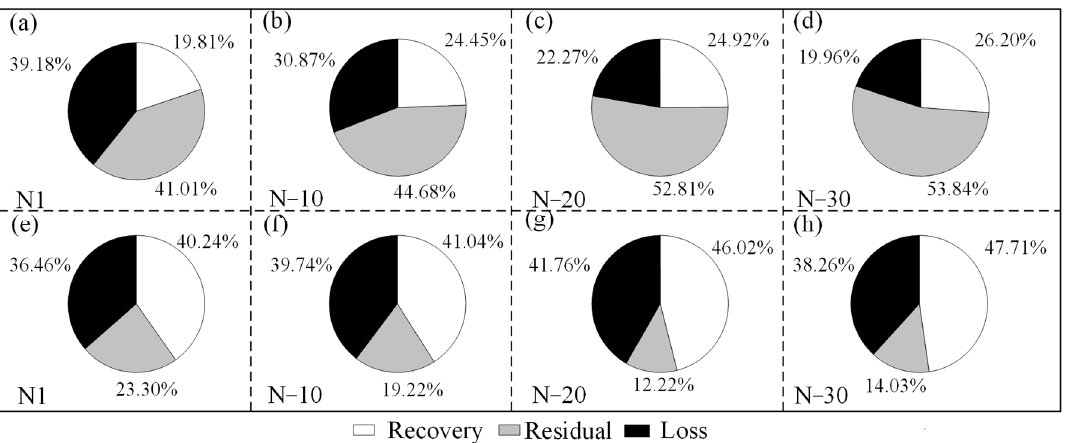
Figure 6. Proportions of nitrogen meeting the three fates for basal fertilizer ( a – d ) and topdressing fertilizer ( e – h ). Note: N0, N1, N − 10, N − 20 and N − 30 represent the five fertilization treatments.